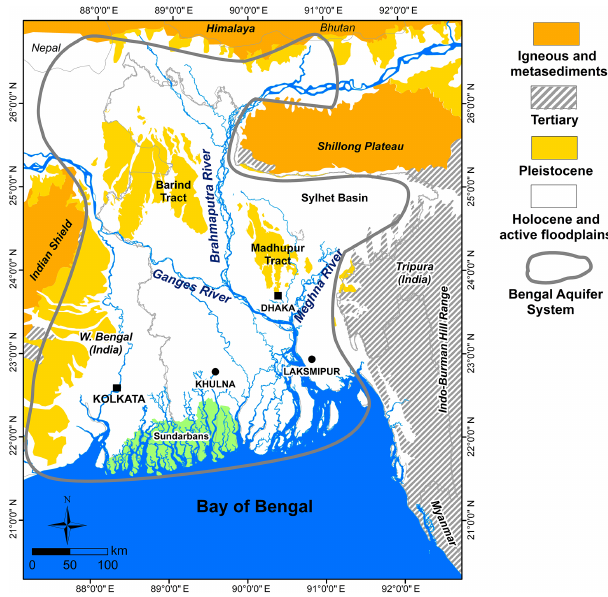
Figure 1. Location map showing the extent of the Bengal Aquifer System (BAS) and the Ganges–Brahmaputra–Meghna (GBM)